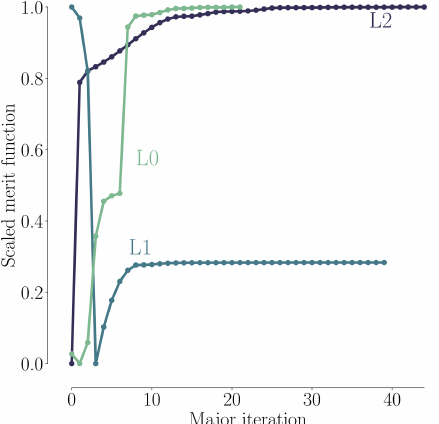
Figure 10. Final chord and twist distributions for the CFD-based planform optimizations.